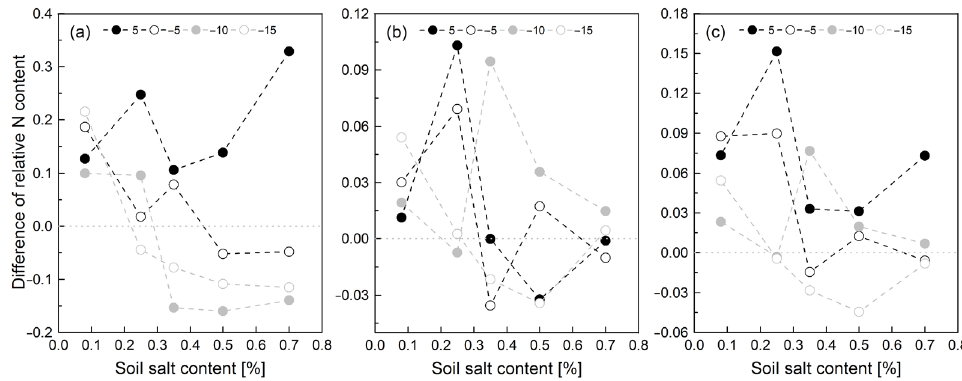
Figure 5. Differences in relative NH 4+ -N ( a ), NO 3 − -N ( b ), and soil inorganic nitrogen (SIN) ( c ) con-